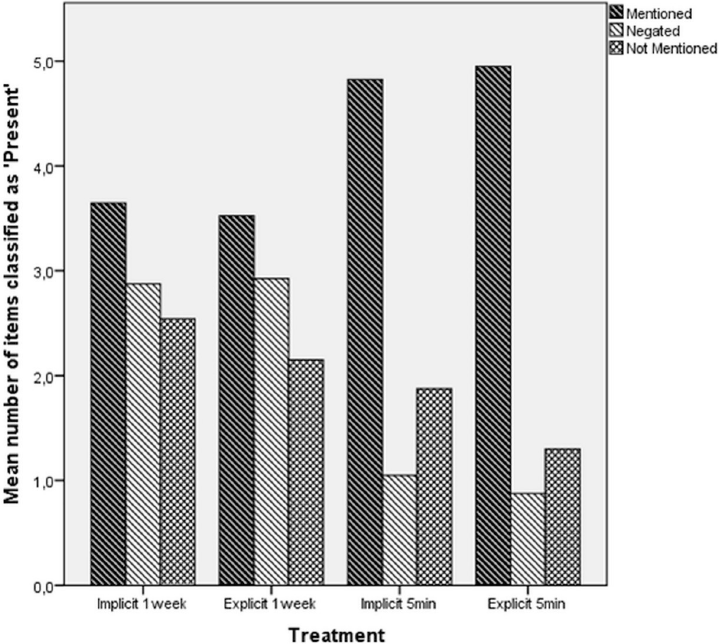
Fig 1. Mean numbers of ‘Present’ answers across information types and